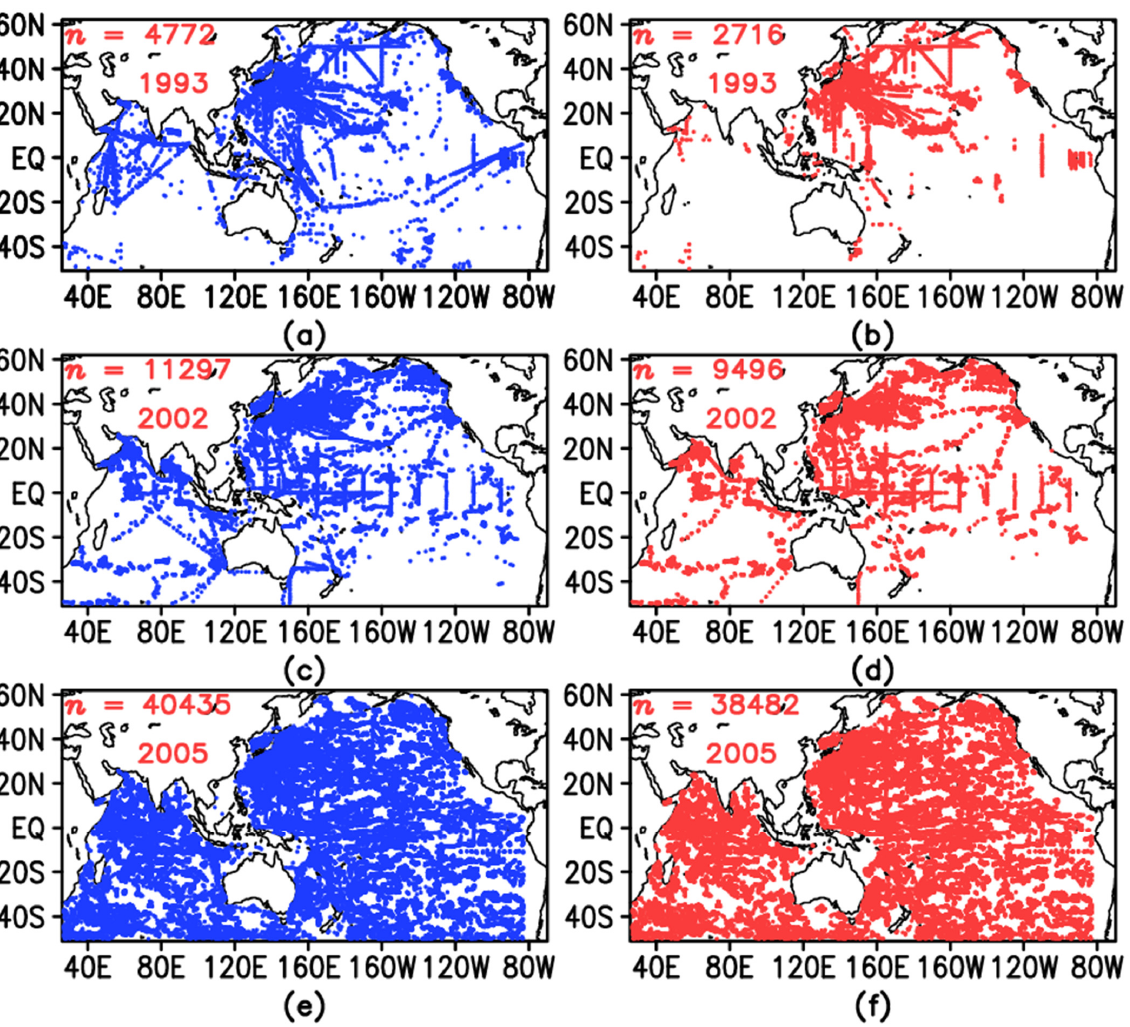
Figure 3. The distribution of the in situ temperature ( a , c , e ) and salinity ( b , d , f ) observations in different years. ( a , b ) 1993, ( c , d ) 2002, ( e , f ) 2005. The n in each figure denotes the number of the profile observations.